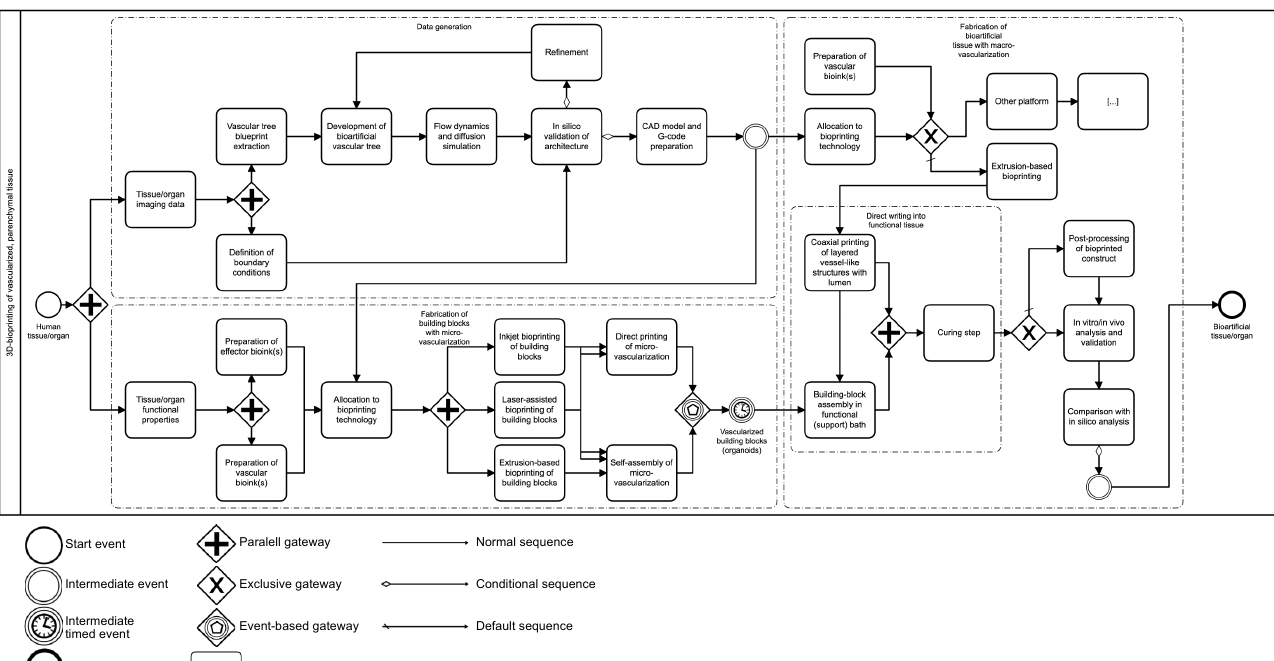
Figure 5. End-to-end manufacturing concept based on imaging data. Discussion of a concept for 3D bioprinting of vascularized parenchymal tissue. Process model for fabrication of vascularized parenchymal tissue potentially integrating several printing technologies in one fabrication process (business process model and notation [BPMN] 2.0).